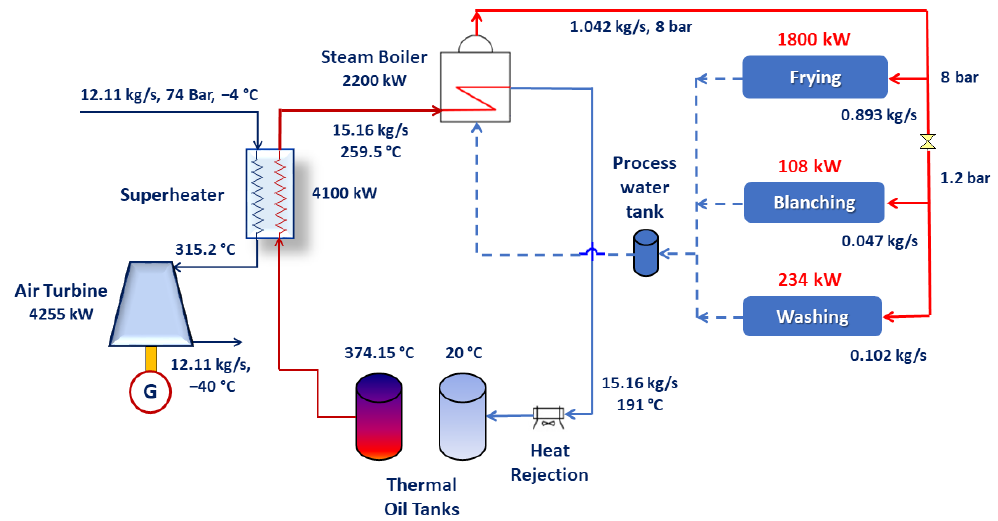
Figure 7. Steam generation and distribution among the consumers along the two studied French fry production lines.